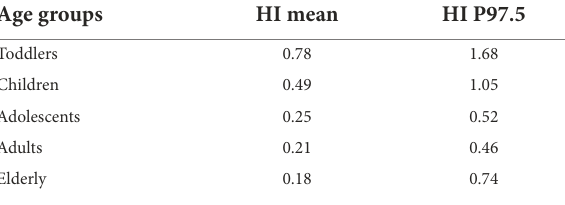
TABLE 7 Hazard index (HI) values, calculated from the median of the mean and 97.5th percentile (P97.5) exposure distributions of the different age groups for the period 2011–2022.